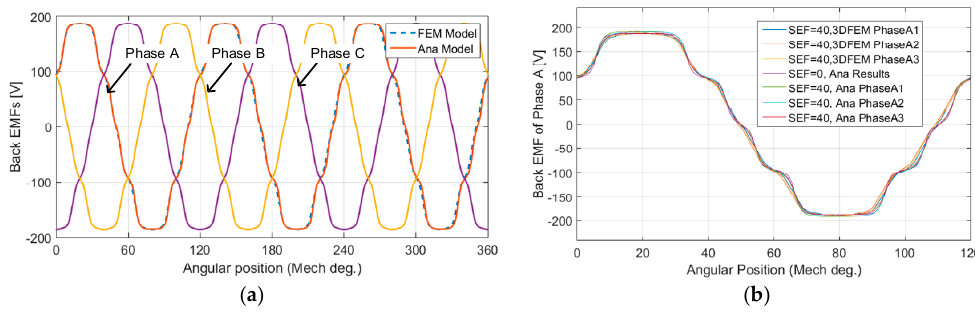
Figure 16. Back electromotive force (EMF) of phase A. ( a ) Health condition; ( b ) SE condition.